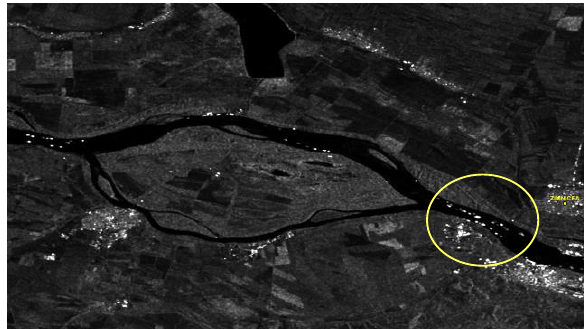
Figure 5. Zimnicea Harbour – 09.08.2015 - Sentinel-1A